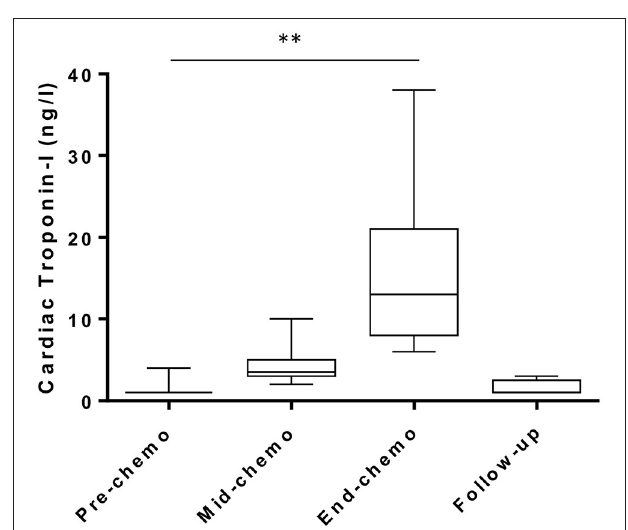
FIGURE 4 | Plasma cardiac troponin levels during chemotherapy in breast cancer patients. High sensitivity cardiac troponin-I levels pre-, mid-, and end-chemotherapy [box and whiskers plot, **indicates P < 0.001 for change from pre-chemo (paired t -test)] and at 2–3 months follow-up in patients with values above the normal range at end-chemo ( n = 9).